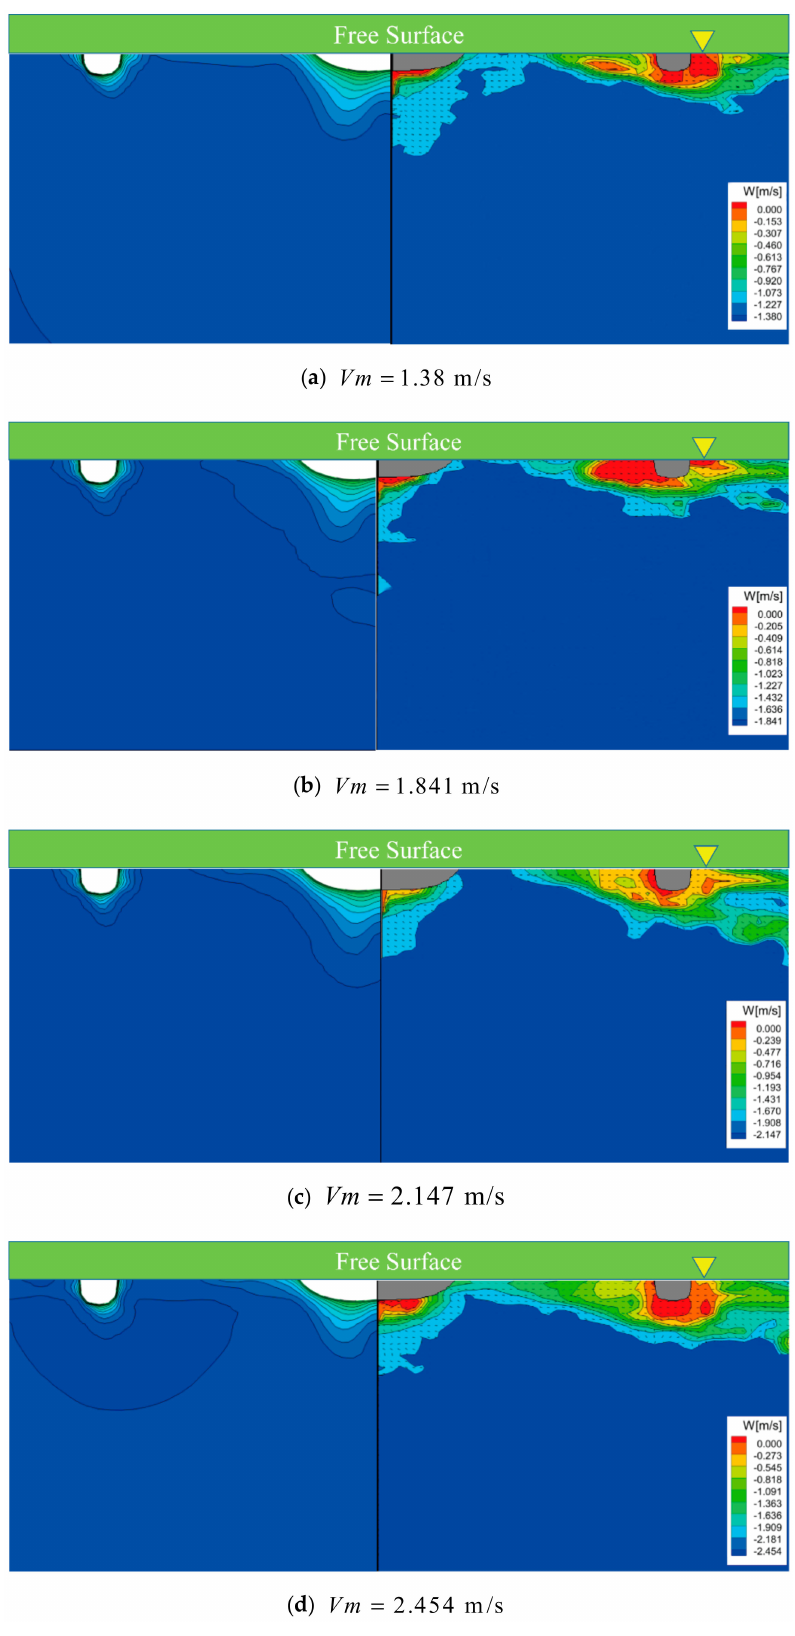
Figure 17. Wake distribution between main body and demi-body at x / Lpp = − 0.4833 (( left ): CFD, ( right ):